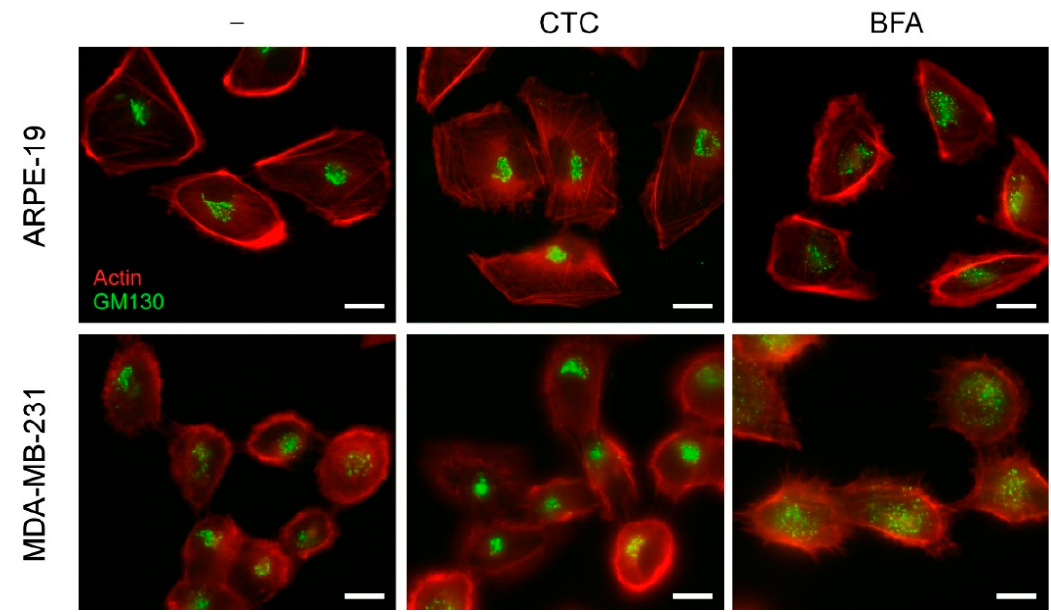
Figure A1. CTC does not affect Golgi morphology. ARPE-19 and MDA-MB-231 cells were treated with CTC at 100 µM and BFA at 10 µg/mL. ARPE-19 and MDA-MB-231 cells were treated for 2 h and 45 min, respectively. Golgi morphology immunofluorescent staining was performed using anti-GM130 antibody. Representative images of cells stained for the cis-Golgi GM130 (green) and F-actin markers (Phalloidin; red). Scale bar: 10 µM.